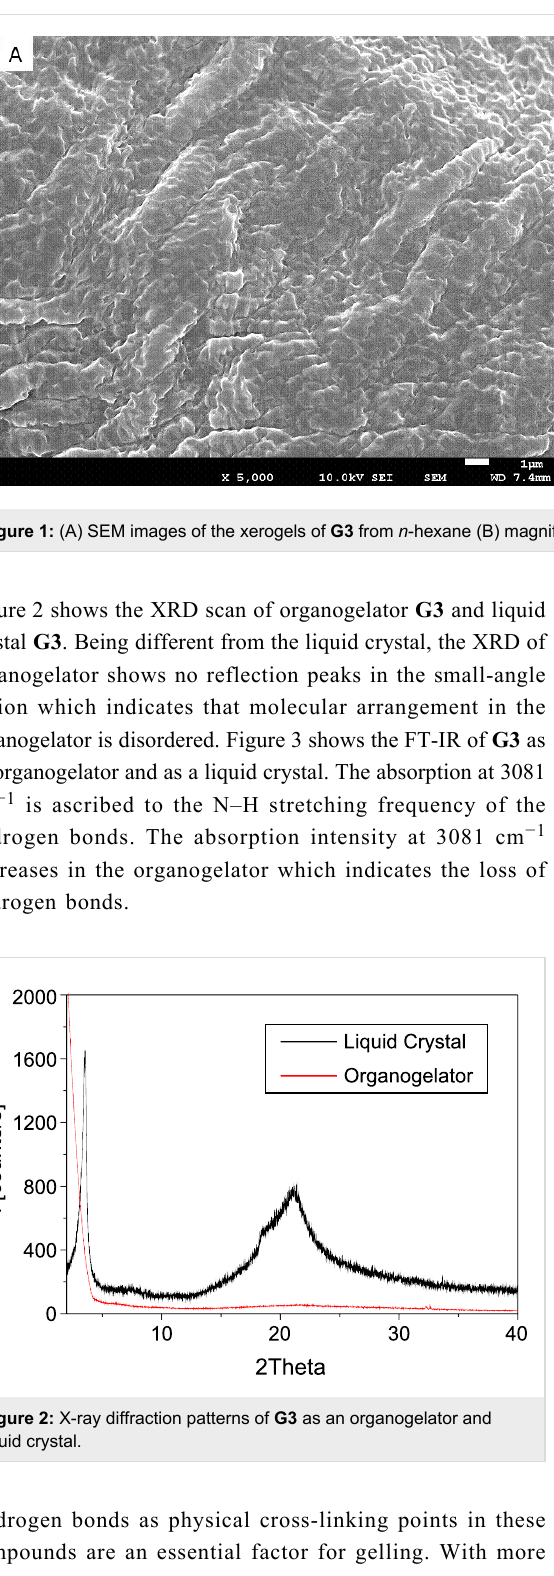
Hydrogen bonds as physical cross-linking points in these compounds are an essential factor for gelling. With more physical cross-linking points, compound G3 gels more easily. Compound G2 can gel only in n -hexane. Compared with the other solvents, n -hexane is a poor solvent, in